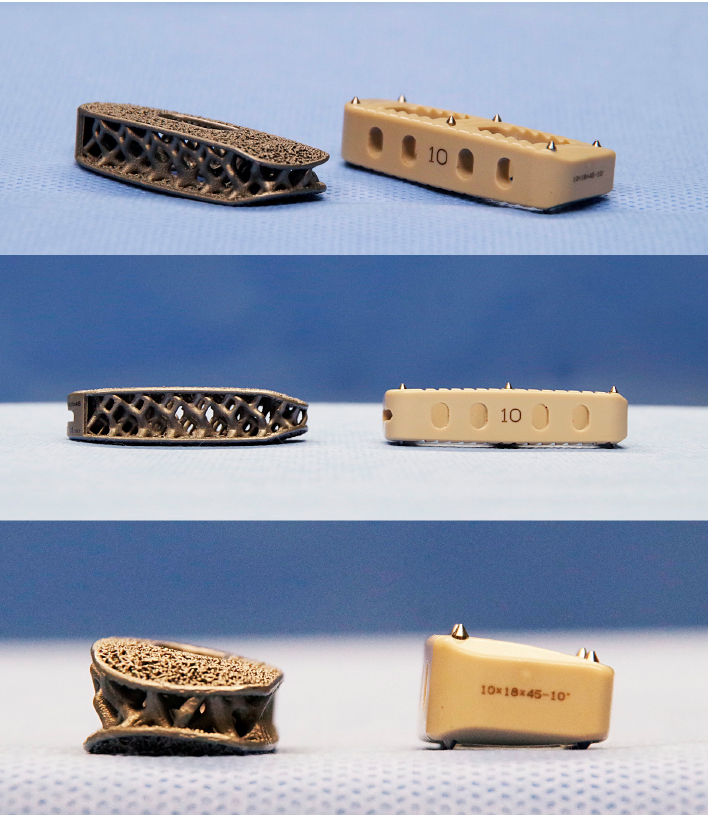
Figure 3. Appearance of 3DTi and sPEEK cages. The 3DTi cages are bullet ‐ shaped and have smooth surfaces. The sPEEK cage has angular corners, spikes, and serrations.